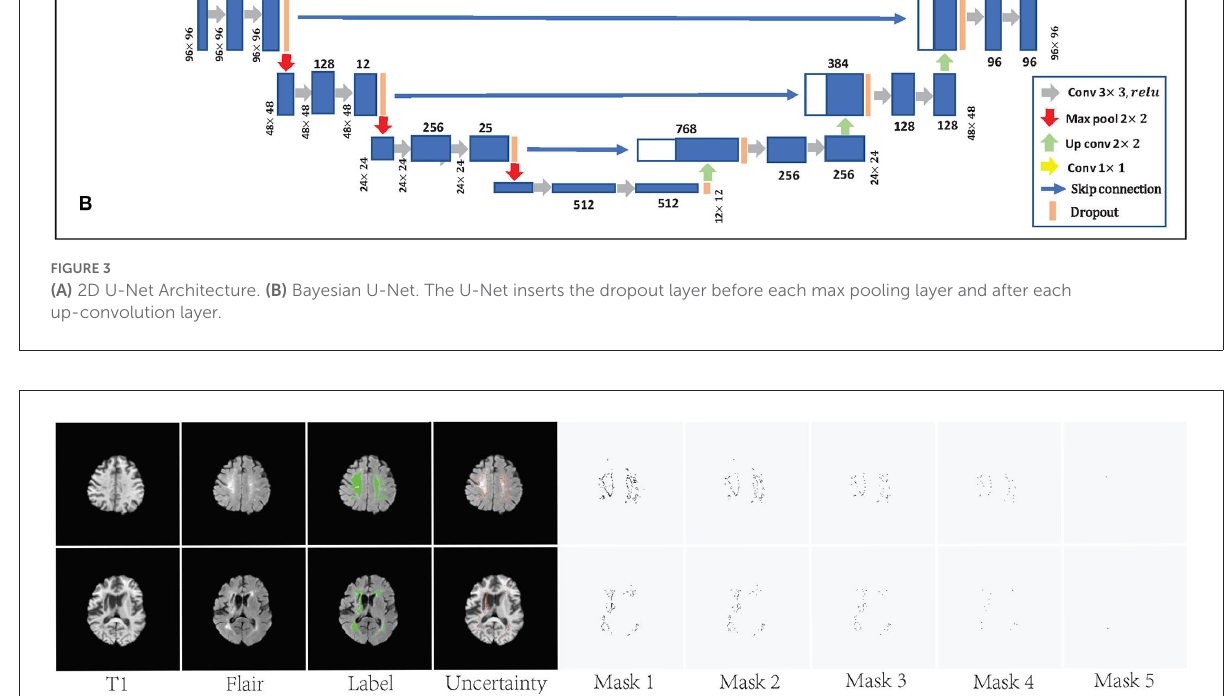
an ensemble of three U-Net’s with different random weight initializations to automatically detect WMH. Li et al. (2022) present a pipeline using deep fully convolutional network